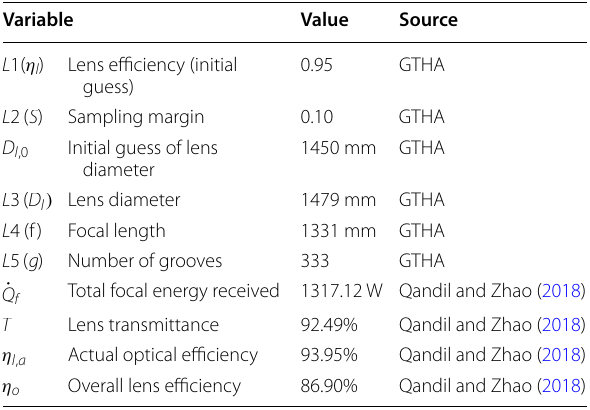
Table 3 Used thermal and mechanical properties of the aluminum heater and ceramic-fiber blanket Aluminum